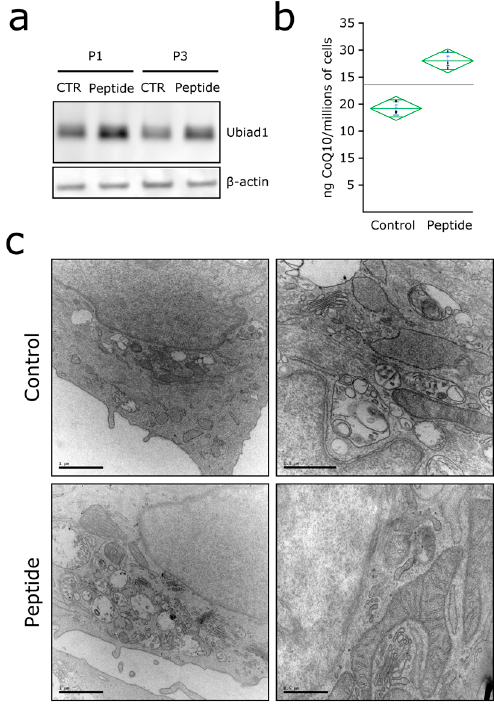
Figure 4. Modulation of Ubiad1 expression and CoQ10 synthesis by synthetic peptide. ( a ) Immunoblotting of Ubiad1 after treatment with the synthetic peptide (P1 = culture passage number 1 and P3 = culture passage number 3); ( b ) HPLC analyses of endogenous CoQ10 in HaCaT after treatment with the synthetic peptide, quantification graph with One-Way Analysis of Variance, displaying confidence interval means diamonds (green). The line across each diamond represents the group mean. The vertical span of each diamond represents the 95% confidence interval for each group. Grand sample mean is represented by a horizontal black line; ( c ) Representative electron microscopy images of an average cell treated with the peptide and double-stained with uranyl acetate and lead citrate (left pictures scale bar = 1 µm; right pictures scale bar = 0.5 µm).